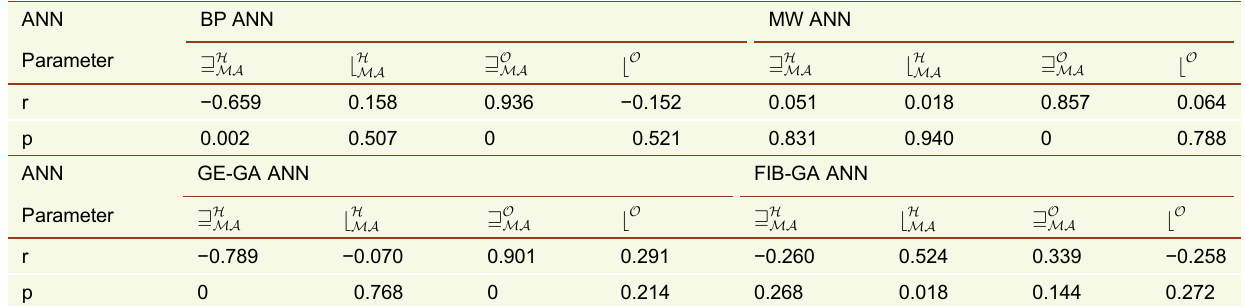
Table 1. Correlation between each category of parameters and average